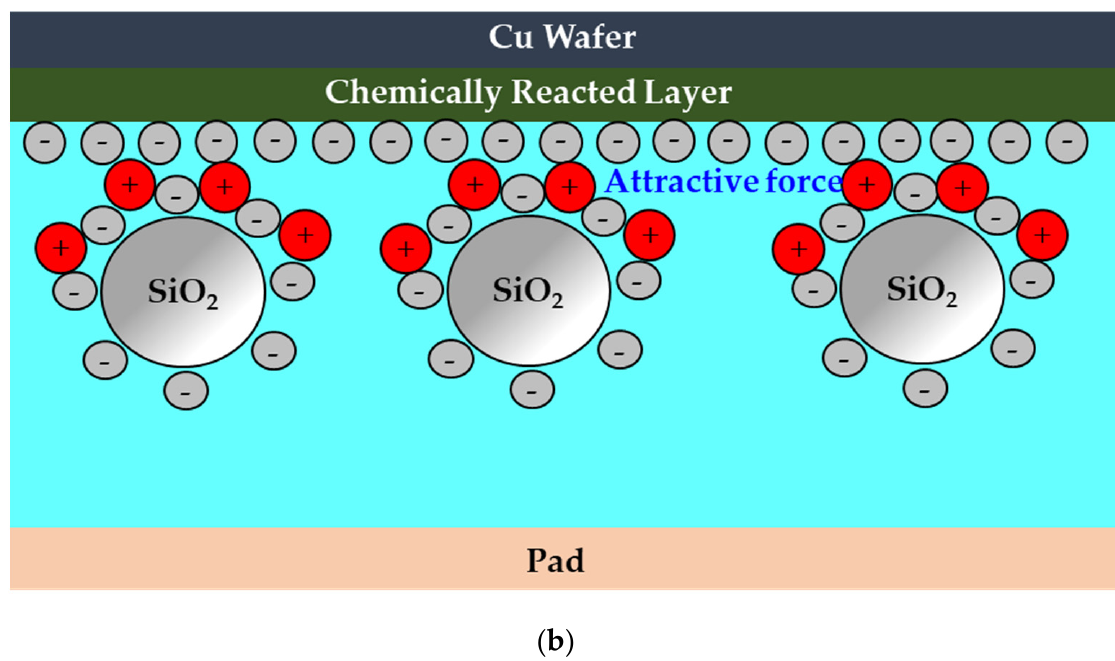
Figure 12. Comparison of conceptual illustrations between the ( a ) conventional and ( b ) ionized slurry.